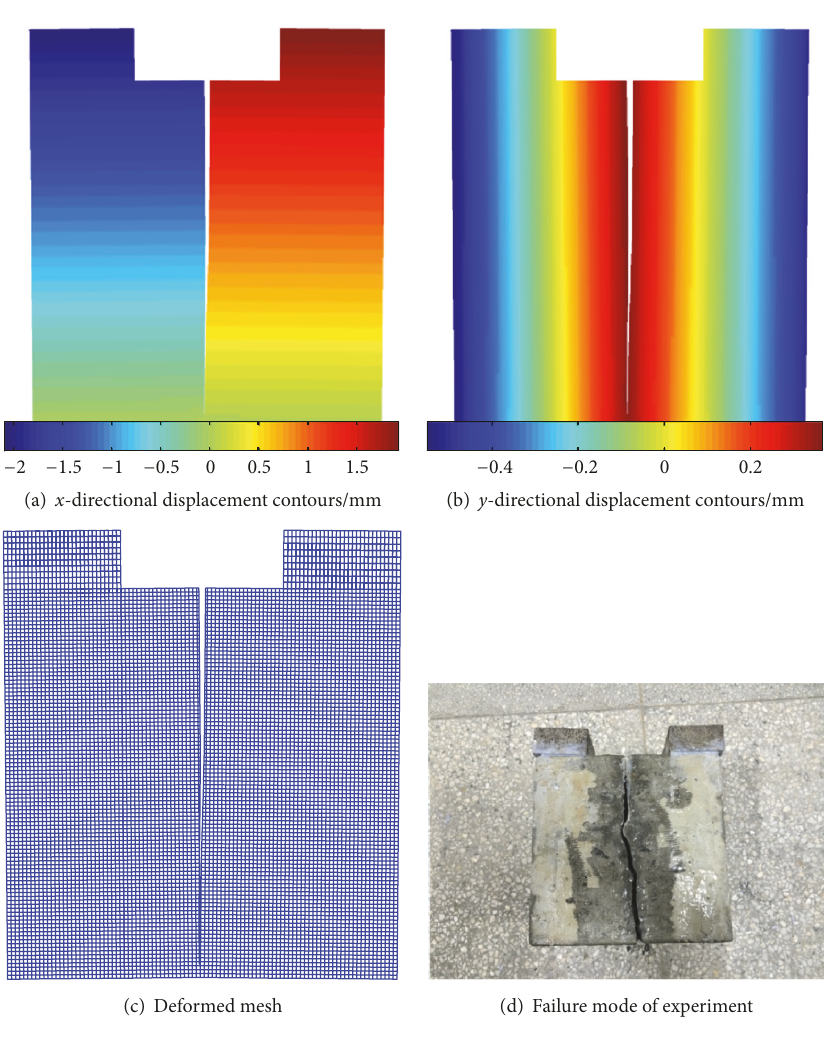
Figure 16: Failure mode for fast loading case with 𝑝 𝑛 =